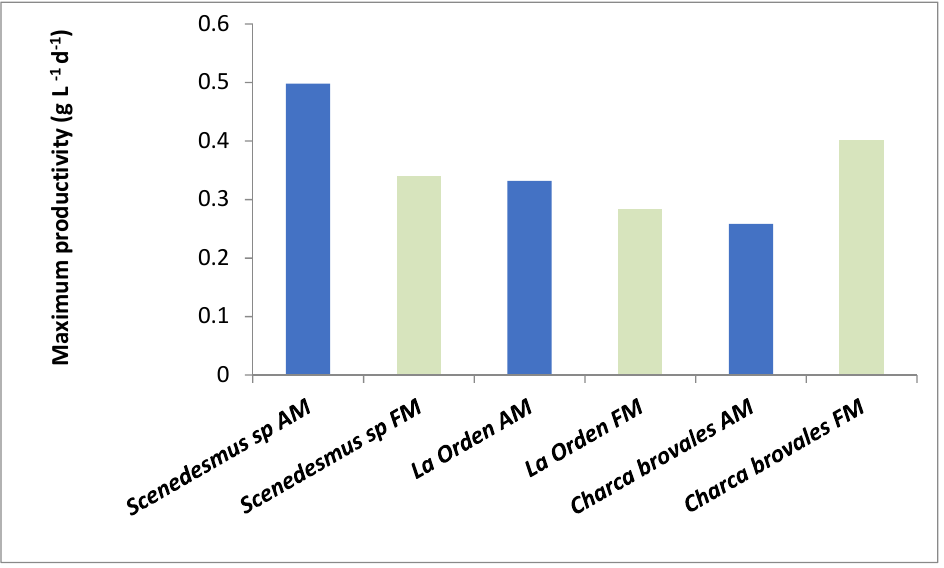
Figure 7. Maximum productivity for the different microalgae populations.